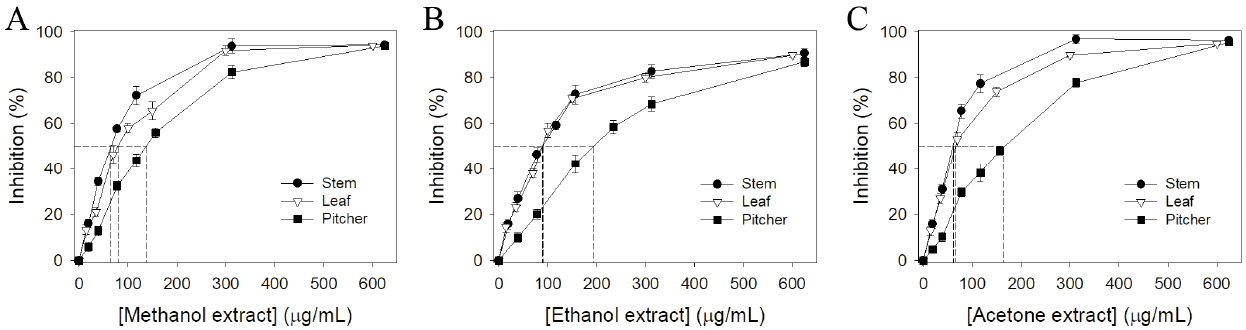
Table 1. Antioxidant activities of N. miranda extracts.